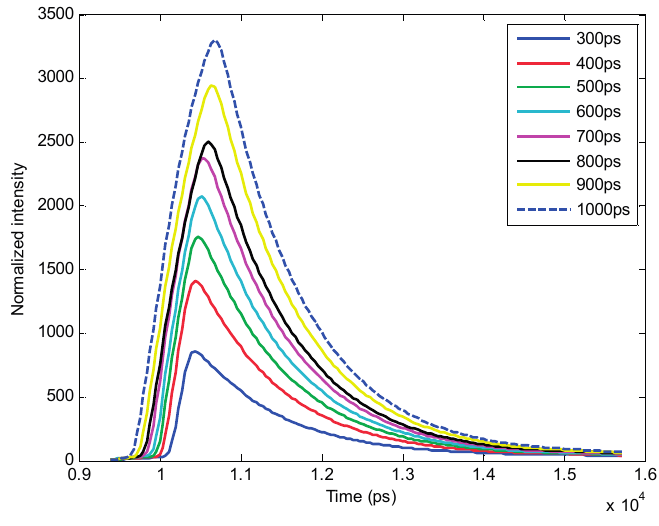
Figure 8. TPSFs of each gate width show increased maximum photon counts.